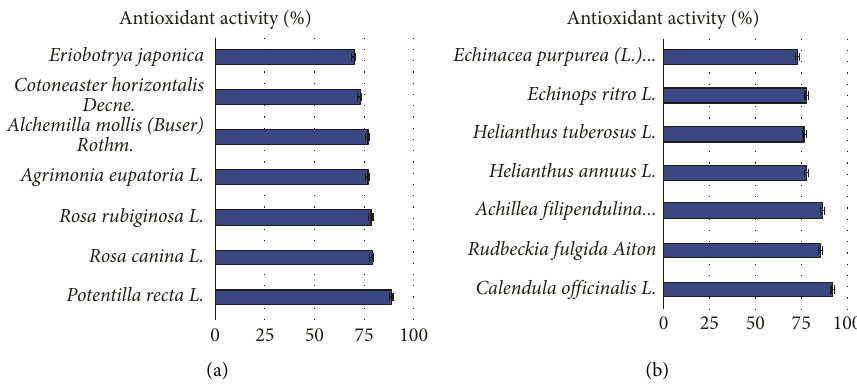
Figure 5: antioxidant activity of the experimental extracts of plant species Rosaceae (a) and Asteraceae (b) families.